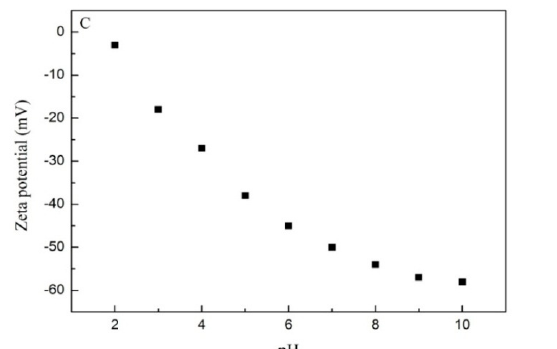
Figure 2. ( A ) Effect of pH on Zn(II) adsorption onto GO in the presence of 0.001, 0.01, and 0.1 mol/L NaClO 4 ; ( B ) Distribution of Zn(II) species in aqueous solution ( C 0 = 10 mg/L, m/v = 0.12 g/L, t = 24 h, T = 293 K); ( C ) Zeta potential of GO dispersion as a function of pH value.